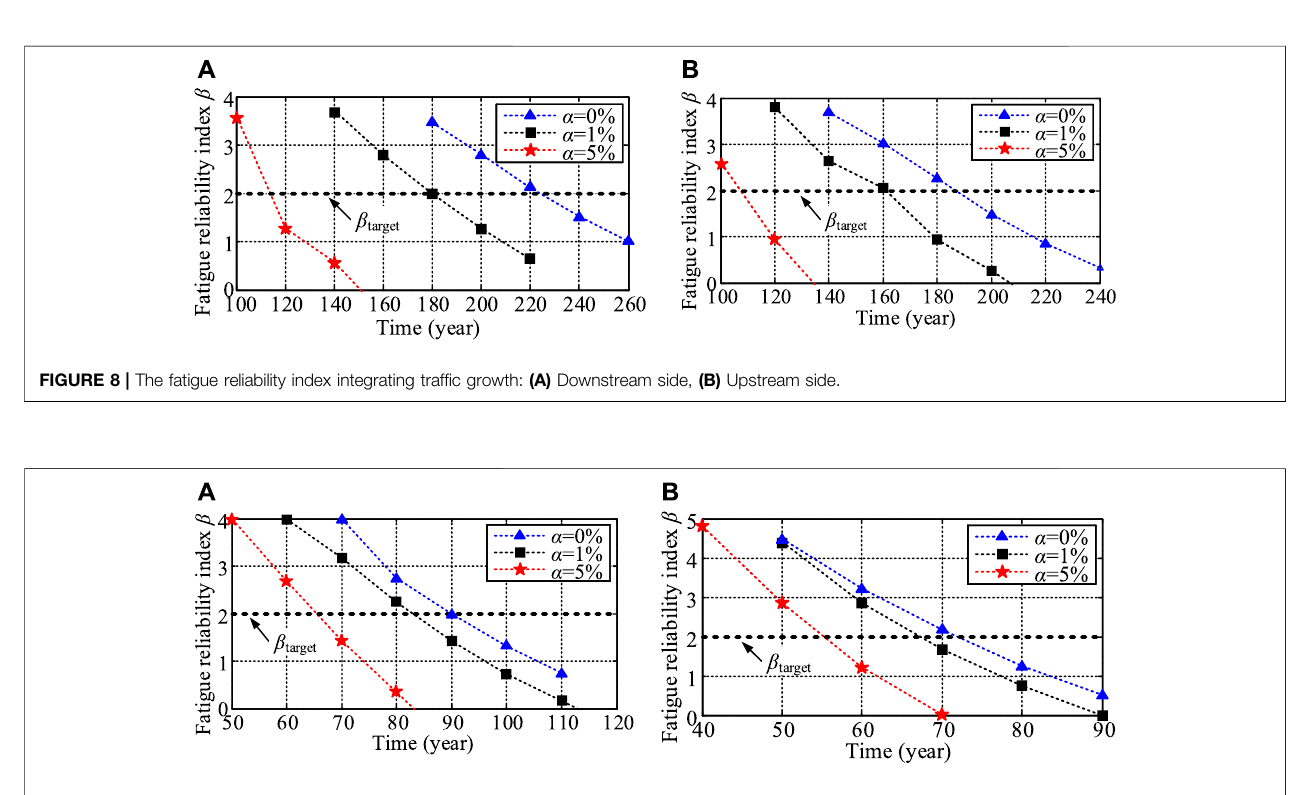
FIGURE 9 | The fatigue reliability index integrating initial damage: (A) Downstream side, (B) Upstream side.